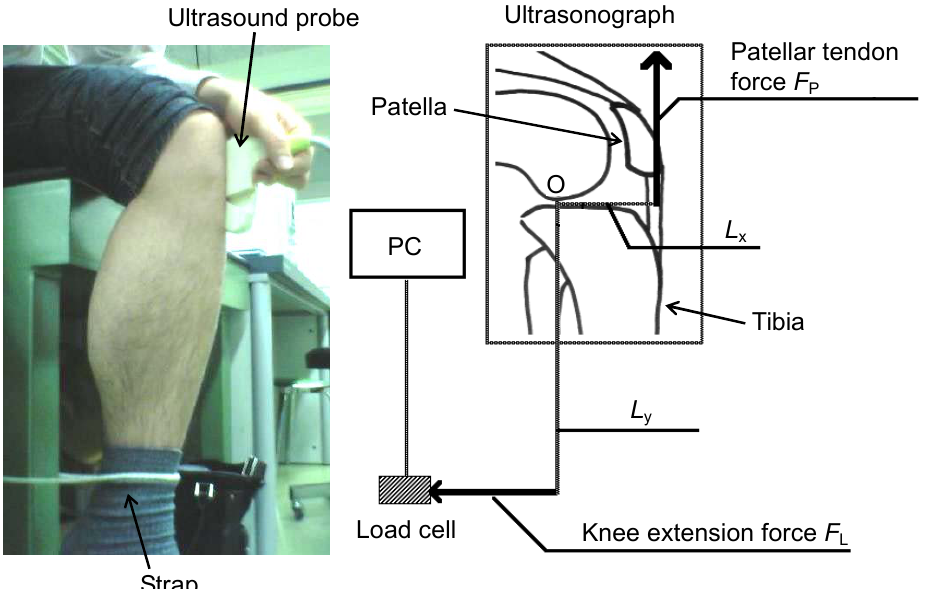
Fig. 1 Schematic diagram of in vivo measurement for the mechanical properties of the patellar